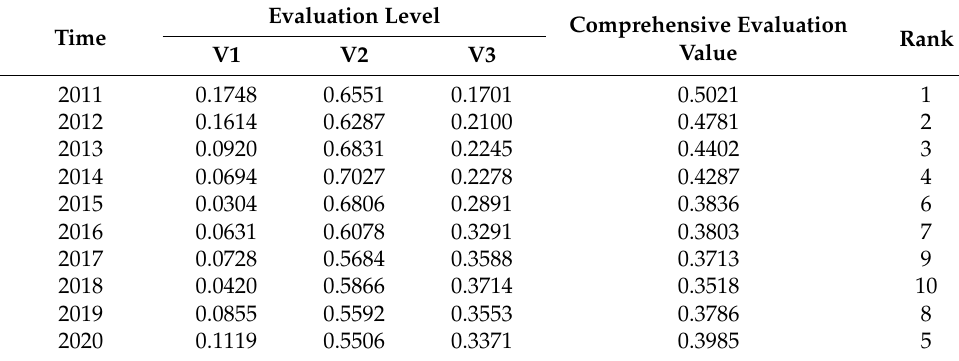
Table 11. Groundwater resources carrying capacity calculation results.